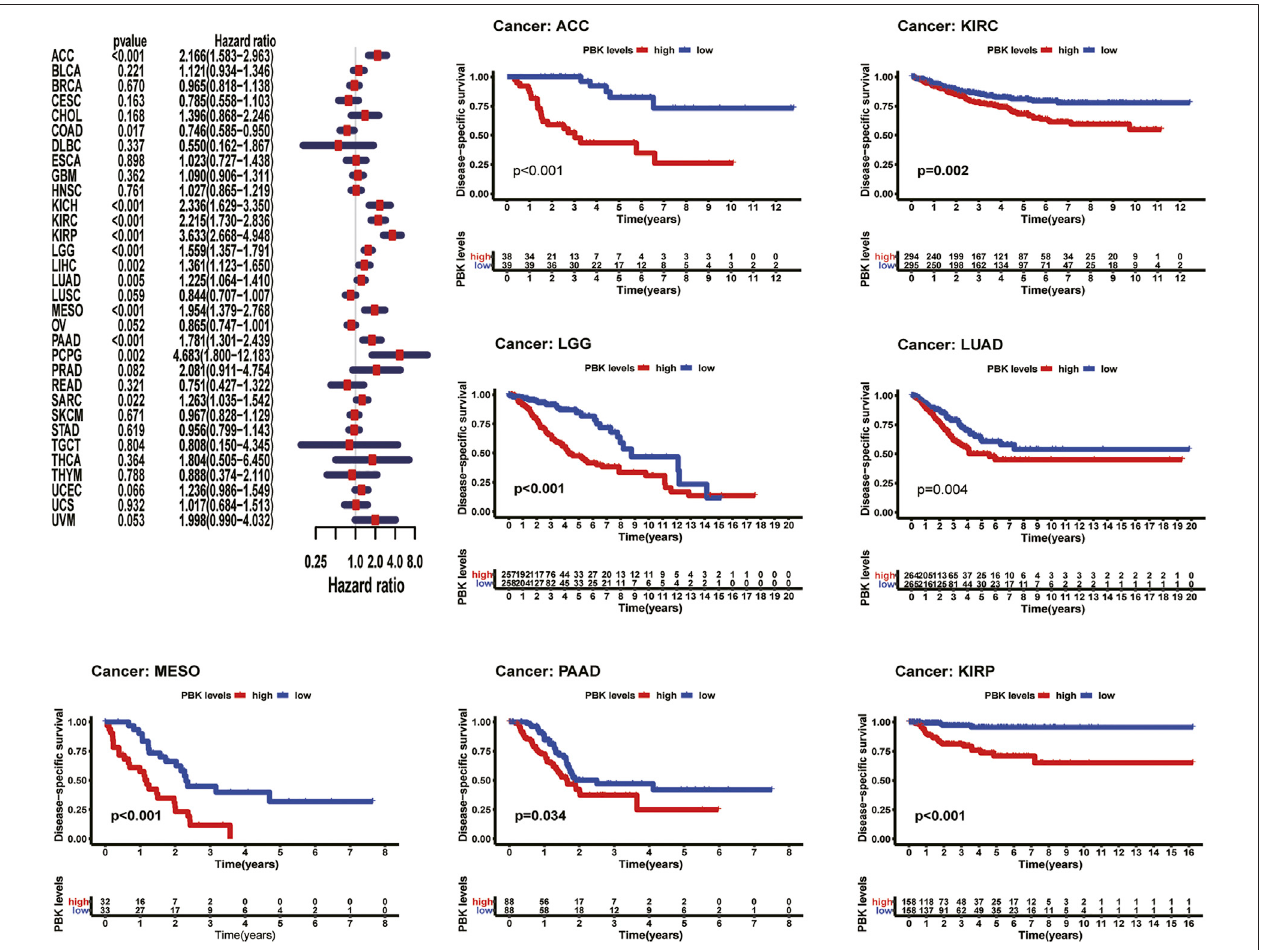
FIGURE 4 | | Relationship of PBK expression with patients ’ PFI. Forest plots of hazard ratios of PBK in 33 cancer types. Kaplan – Meier PFI curves for patients strati fi ed by different expression levels of PBK in nine cancer types.